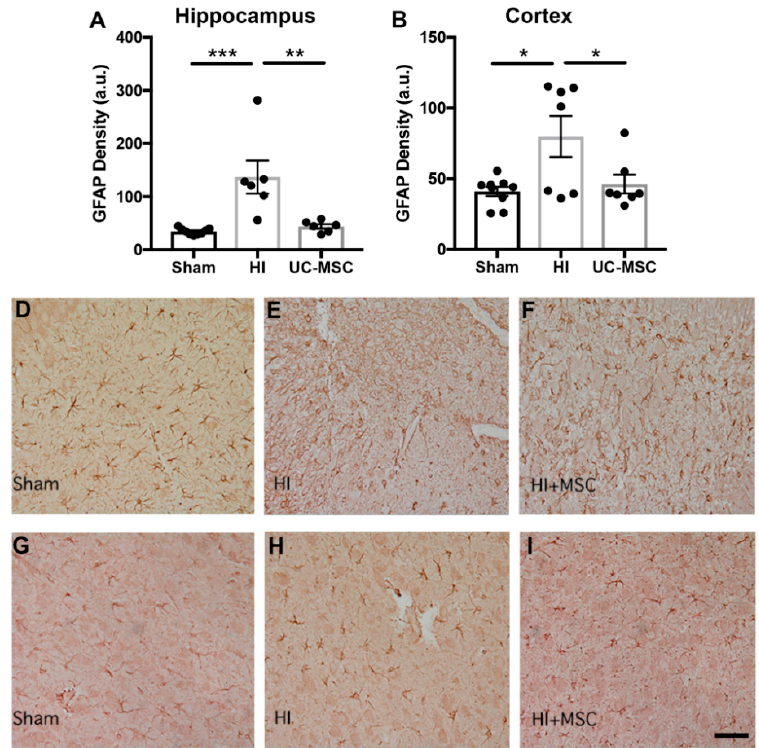
Figure 5. Astrogliosis is increased in the hippocampus after neonatal HI brain injury and reduced by UC-MSC treatment. Glial fibrillary acidic protein (GFAP) immunohistochemistry was performed to assess astrocyte density in the ( A ) hippocampus and ( B ) somatosensory cortex. Representative images of GFAP staining in the hippocampus for ( D ) sham, ( E ) HI and ( F ) MSC treatment. Representative images of GFAP staining in the somatosensory cortex for ( G ) sham, ( H ) HI and ( I ) MSC treatment. All images were taken at 400× magnification, scale bar = 500 μ m (a.u.—arbitrary units, n = 6–9 rats per group, * p < 0.05, ** p < 0.01, *** p < 0.001).